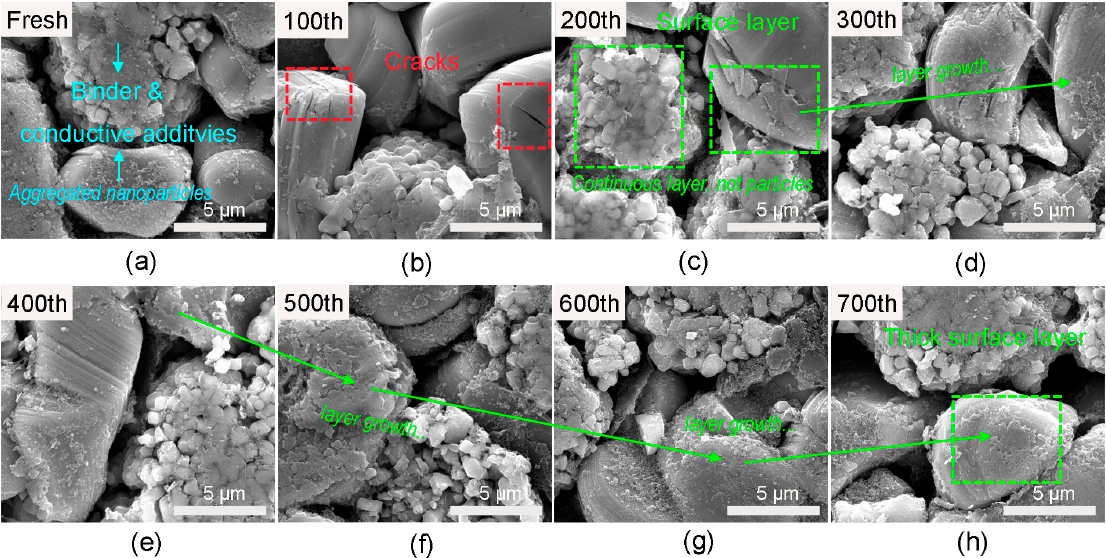
Figure 6. Field Emission Scanning Electron Microscopy (FESEM) images of harvested LCO + NMC532 cathode electrodes experienced various cycles at high magnification: ( a ) fresh; ( b ) 100th; ( c ) 200th; ( d ) 300th; ( e ) 400th; ( f ) 500th; ( g ) 600th; ( h ) 700th.